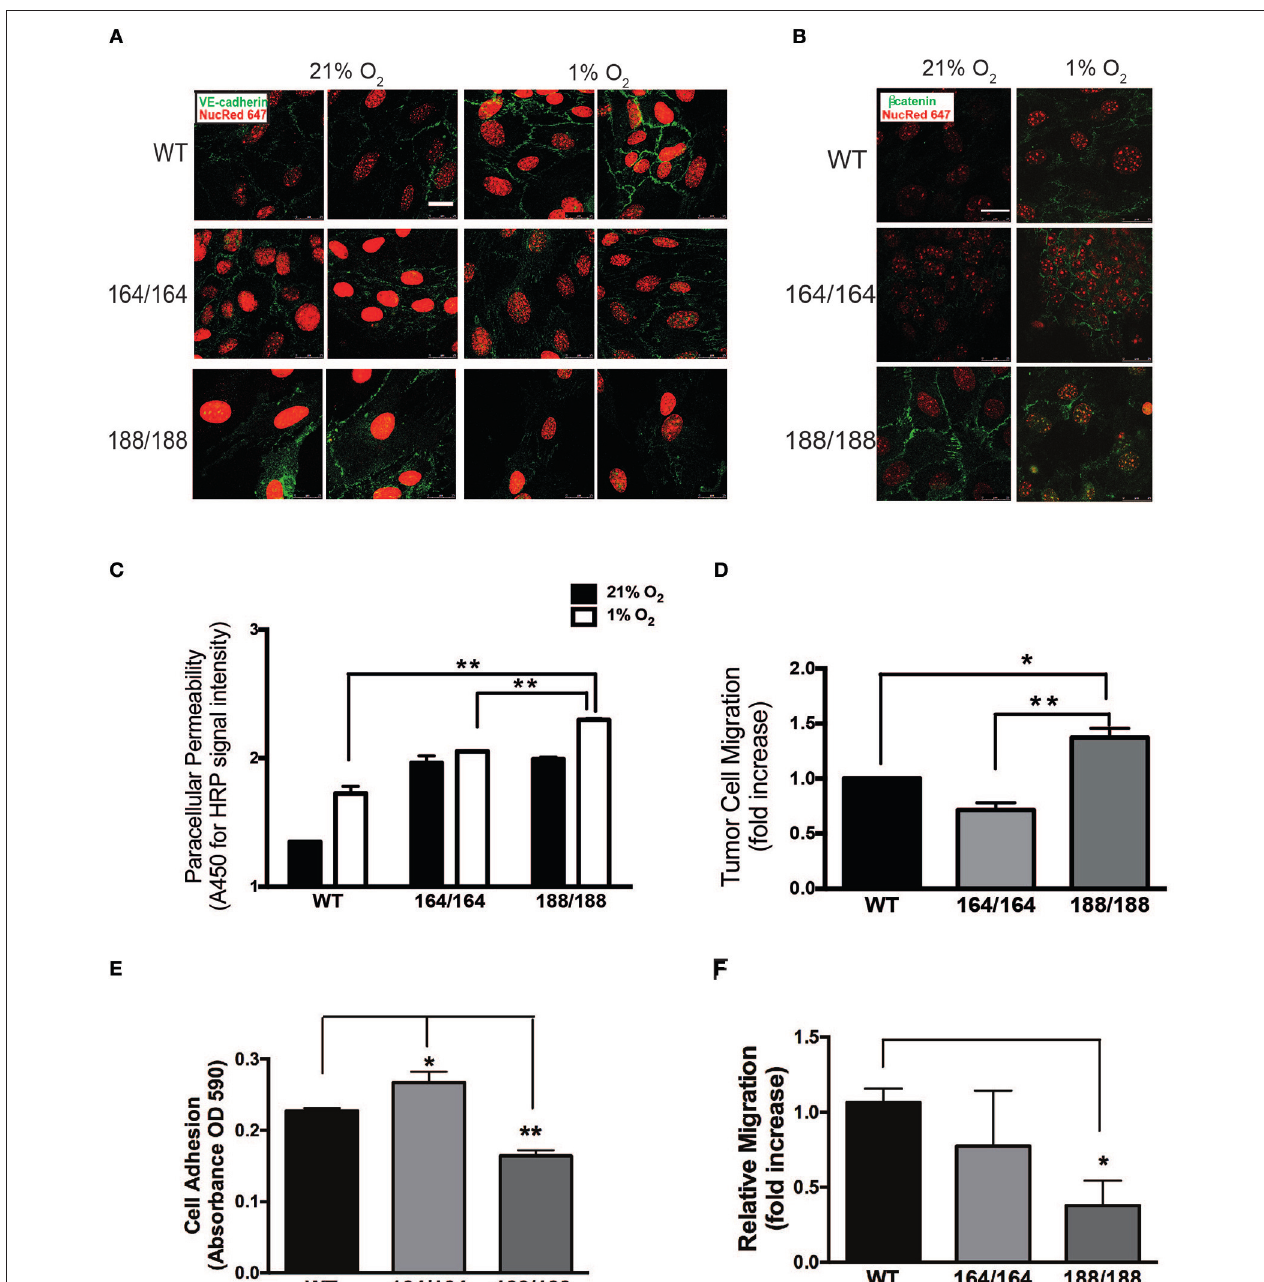
FIGURE 2 | Endothelial integrity as a function of isoform-specific VEGF signaling. (A) Normoxic and hypoxic (1% O 2 , 24 h) EC were fixed and immunostained with VE-cadherin and (B) β -catenin antibodies and detected by immunofluorescence. Targets are shown in green, nuclei in red; scale bars, 25 µ m. (C) EC monolayers were grown in 0.4 µ m pore Boyden chamber filters. To assess paracellular permeability, normal medium was replaced with medium containing HRP-streptavidin ( ∼ 100 kDa), which was quantified in the lower chamber 1 h after normoxic or hypoxic incubations using a peroxidase-coupled assay; data shown are absorbance values at 450 nm. (D) Tumor cell invasion assay: GFP-labeled Lewis Lung Carcinoma cells (LLC GFP ) were seeded over endothelial monolayers in 8 µ m pore filters; fluorescent cells were counted on the opposite side of the filter after 24 h at 1% O 2 . Results shown in (C) and (D) are average ± SEM ( n = 3); three wells isolated from three mice per each group. (E) A suspension of 1.0 × 10 5 endothelial cells was seeded onto fibronectin-coated plates and washed with PBS 30 min later. Adherent cells were stained with Crystal Violet, which was subsequently extracted and quantified by spectrometry. Results shown are average ± SEM ( n = 3); three wells, each containing cells isolated from 2 to 4 mice. (F) Scratch assay performed on endothelial cell monolayers, and cell migration was quantified 24 h after monolayer disruption by measuring scratch width after 24 h in at 1% O 2 . Results shown are average ± SEM ( n = 4); four fields, each of cells isolated from 2 to 4 mice. * P < 0.05, ** P < 0.005.